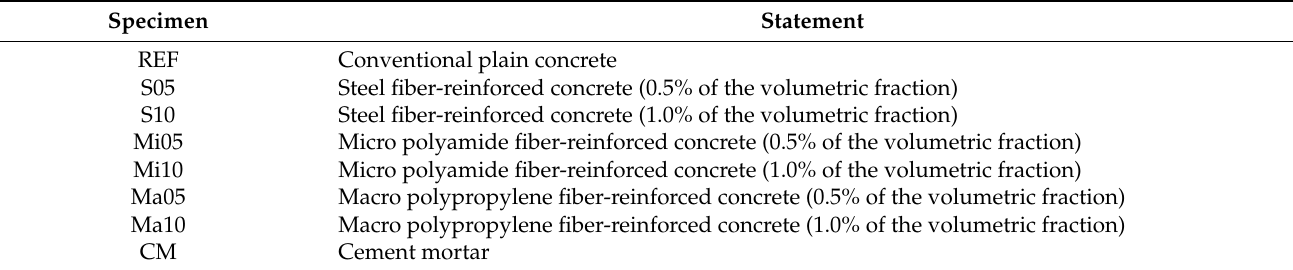
Table 1. Descriptions of the test specimens.